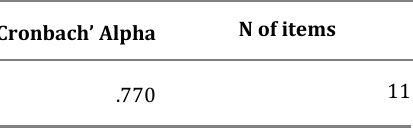
Table 4 Instrument Validity Result Test